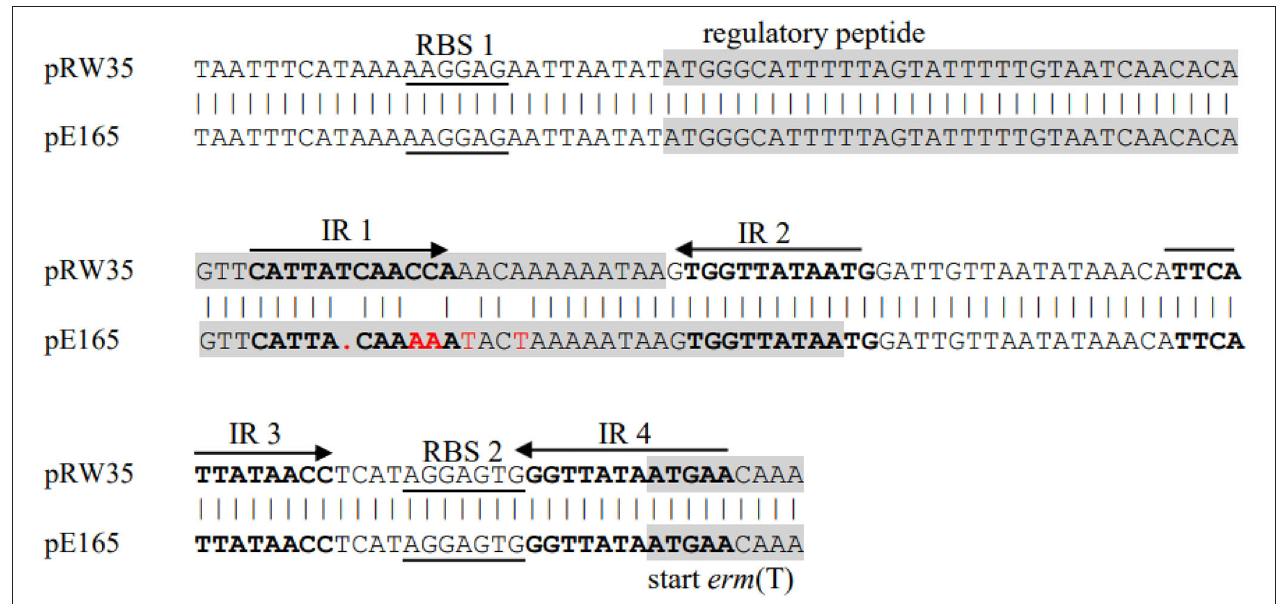
FIGURE 2 | Alignment of erm (T) regulatory region of pRW35.seq (upper line) and erm (T) regulatory region of pE165.seq (lower line). Identity = 97.40%(150/154), Gap = 0.65%(1/155).